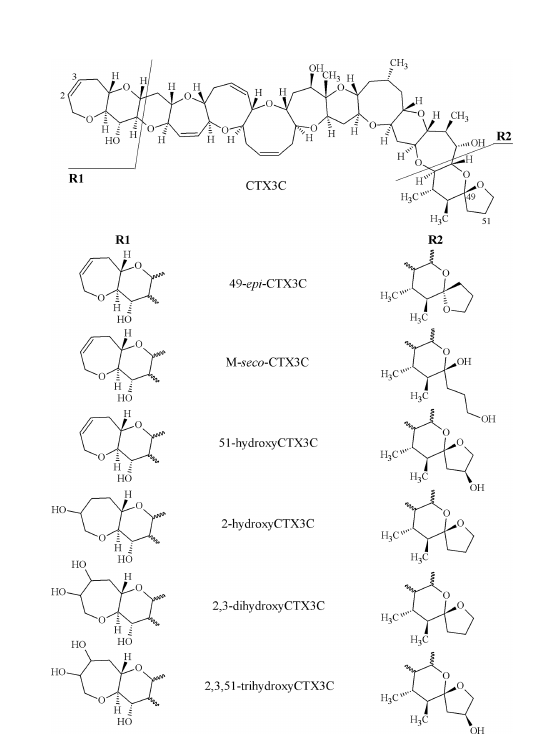
FIGURE 2 Structures of congeners of the CTX3C-group detected in sample extracts within this